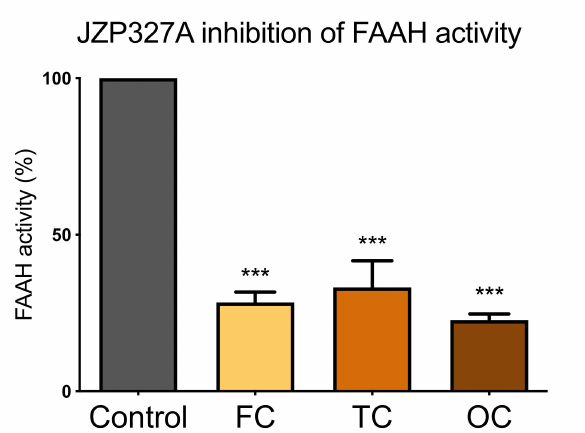
Figure 6. FAAH inhibitor JZP327A reduces basal FAAH activity in vitro at the cortical level. Data is from ABPP testing of the frontal cortex (FC), temporal cortex (TC) and occipital cortex (OC) proteomes incubated for 1 h with vehicle (DMSO) and the specific FAAH inhibitor JZP327A (1 µ M). Notice that JZP327A reduced FAAH activity by 72% in FC, 67% in TC and 78% in OC. One-way ANOVA with Tukey’s multiple comparison post-hoc test was used for comparison, *** p < 0.001, n =